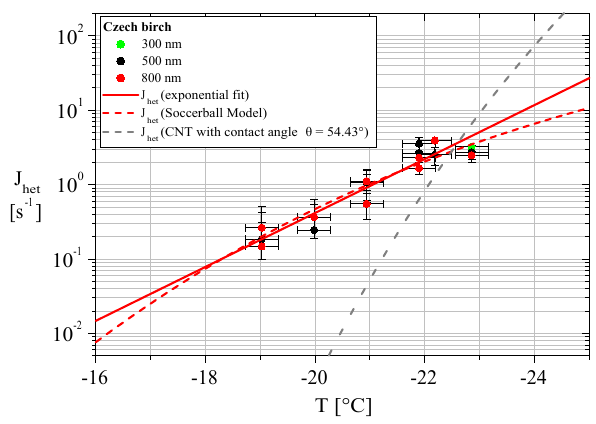
Fig. 4. Heterogeneous ice nucleation rate ( J het ) for 300, 500 and 800nm particles of Czech birch pollen washing water particles as a function of temperature T (colored dots) and parameterized J het . Straight line: simple exponential fit of J het with A = 2 . 320 × 10 − 8 and B = − 0 . 835 ◦ C − 1 ; dotted line: SBM with µ = 58 . 2 ◦ and σ = 4 . 6 ◦ ; and gray dotted line: SBM with one contact angle µ = 54 . 43 ◦ .